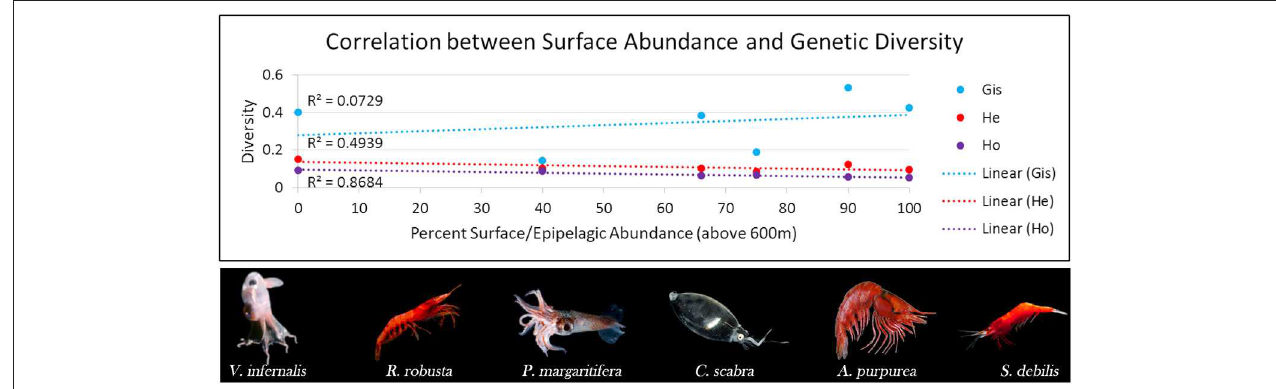
FIGURE 6 | Graph relating genetic diversity (inbreeding coefficient [G IS ] in blue, expected heterozygosity [H e ] in red, and observed heterozygosity [H o ] in purple) to abundance in the surface/epipelagic (here, we define this as above 600m) across midwater invertebrate species with differing diel vertical migratory behaviors. We find an indirect relationship, with diversity decreasing as the percent of individuals found in the surface/epipelagic increases. This correlation is strongest in H o ( R 2 = 0.87) compared to H e ( R 2 = 0.49) and G IS ( R 2 = 0.073). Robustosergia robusta, Pyroteuthis margaritifera, Cranchia scabra , and Systellaspis debilis photo credit: Dr. Danté Fenolio . Vampyroteuthis infernalis photo credit: David Wrobel . Acanthephyra purpurea photo credit: Dr. T.-Y. Chan.